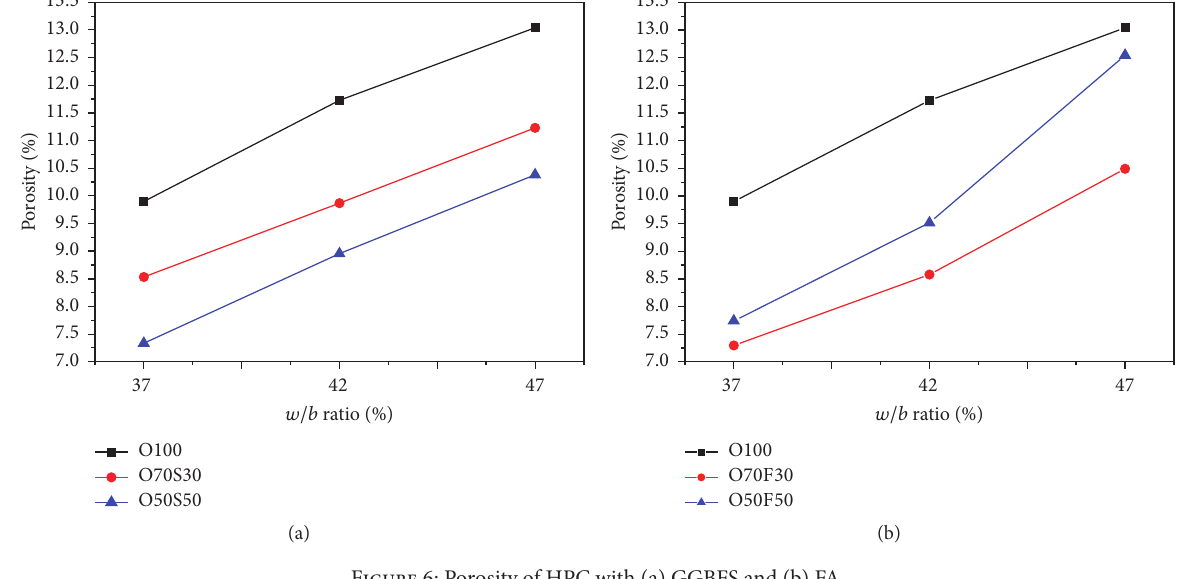
Figure 6: Porosity of HPC with (a) GGBFS and (b) FA.